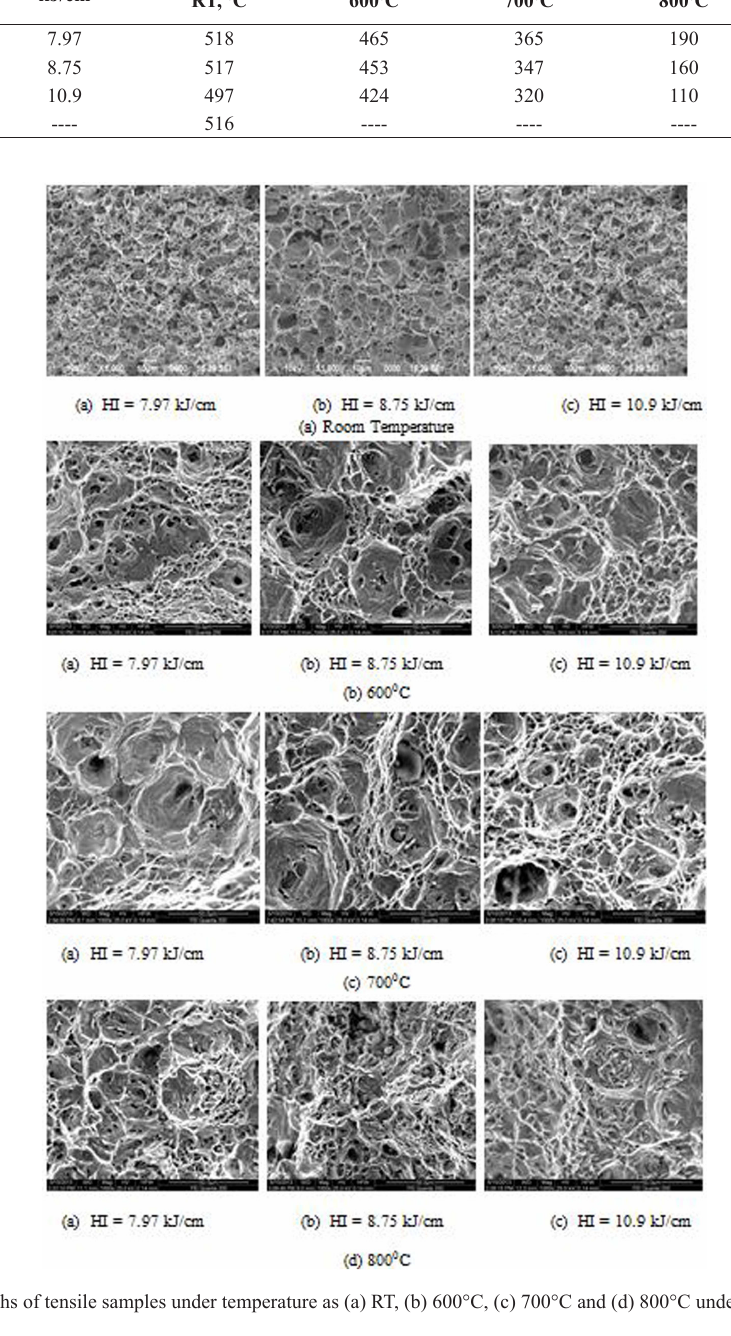
Table 5. Tensile properties and impact toughness of GTA weld joints Exp. No.